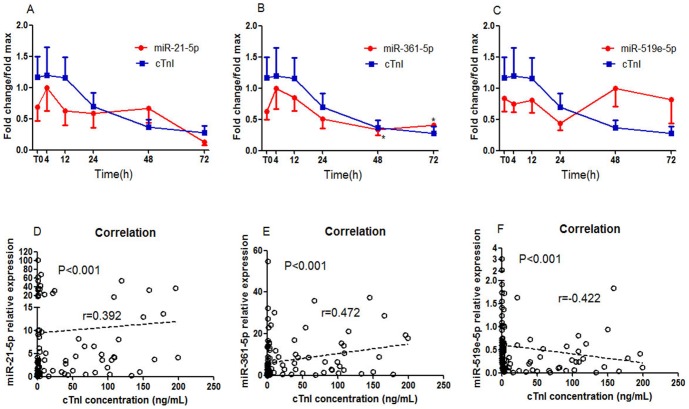
The expression pattern and the correlations between circulating miRNAs and plasma cTnI in AMI patients.(A) the expression trend of circulating miR-21-5p and plasma cTnI in AMI patients; (B) the expression trend of circulating miR-361-5p and plasma cTnI; (C) the expression trend of circulating miR-519e-5p and plasma cTnI; (D) The relationship between circulating miR-21-5p and plasma cTnI in AMI patients; (E) The relationship between miR-361-5p and cTnI; (F) The relationship between miR-519e-5p and cTnI. Data are presented as mean ± SEM, *p<0.05, **p<0.01 versus peak level.